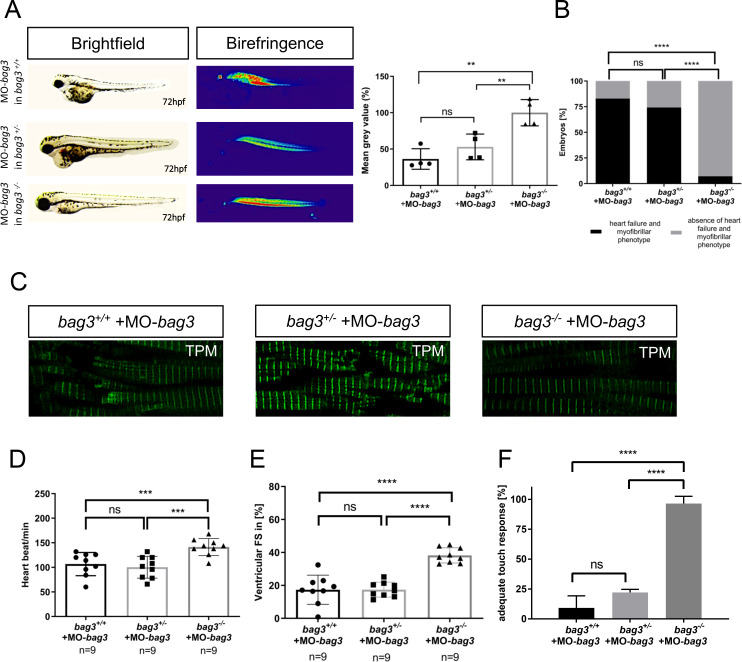
Knockdown of Bag3 leads to heart and skeletal muscle dysfunctions only in bag+/+
and bag3+/-
embryos. (A) Brightfield and birefringence images of bag3+/+, bag3+/- and bag3-/- embryos at 72 hpf injected with MO-bag3. Densitometric analysis of birefringence (n = 4). Representative samples are shown (One-way ANOVA followed by tukey's multiple comparison analysis, P = 0.0012). (B) Only bag3-/- embryos injected with MO-bag3 do not show (cardio-)myopathy, whereas bag3+/+and bag3+/- develop the characteristic bag3 morphant phenotype (N = 3, n = 40, mean ± S.D., P<0.0001, two-tailed value for Fisher´s exact test. bag3+/+ and bag3+/- P = 0.5346; bag3+/+ and bag3-/- P<0.0001; bag3+/- and bag3-/- P<0.0001). (C) Tropomyosin immunostainings of bag3+/+, bag3+/-, and bag3-/- embryos injected with MO-bag3 at 72 hpf reveal that only bag3-/- mutant embryos injected with MO-bag3 does not develop muscle fiber disruptions. (D) Heart rate quantification at 72 hpf reveals impairments only in bag3+/+and bag3+/- embryos injected with MO-bag3 (N = 3, n = 9, mean ± S.D. One-way ANOVA followed by tukey's multiple comparison analysis, P = 0.0008). (E) Quantification of ventricular FS at 72 hpf reveals contractile dysfunctions only in bag3+/+and bag3+/- embryos injected with MO-bag3 (N = 3, n = 9, mean ± S.D. One-way ANOVA followed by tukey's multiple comparison analysis, P<0.0001). (F)
bag3-/- embryos injected with MO-bag3 show proper flight response upon mechanical stimulus, whereas bag3+/+and bag3+/- embryos injected with MO-bag3 do not show an adequate touch response (N = 3, n = 60, mean ± S.D. One-way ANOVA followed by tukey's multiple comparison analysis, P<0.0001).